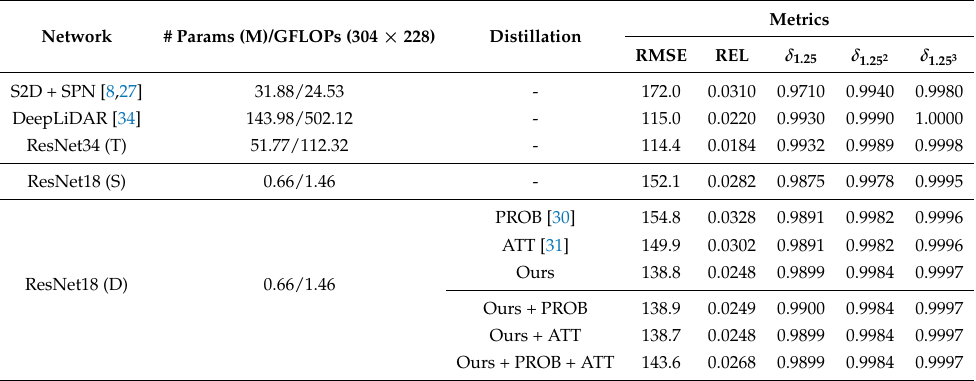
Table 2. Quantitative evaluation results on the NYUv2 validation dataset [28] (T: Teacher, S: Student, D: